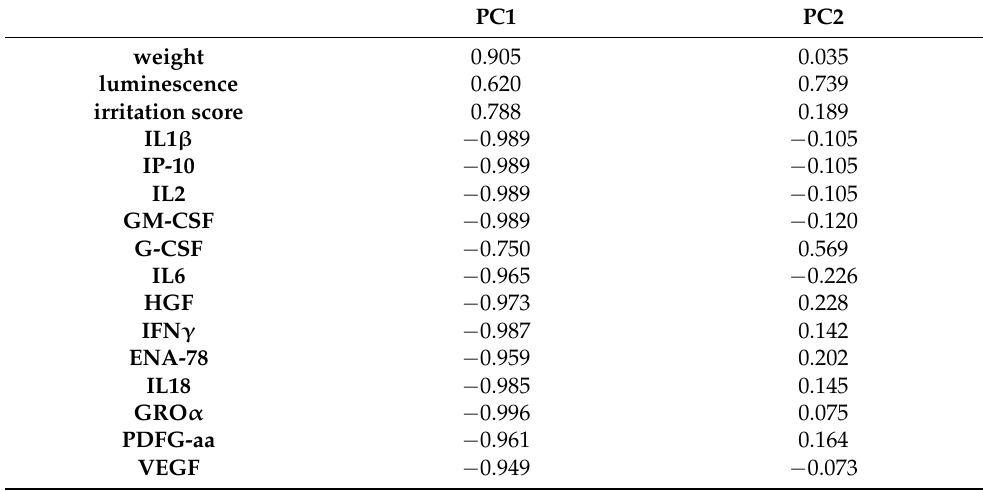
Table A1. PC scores of loadings. PC = principal